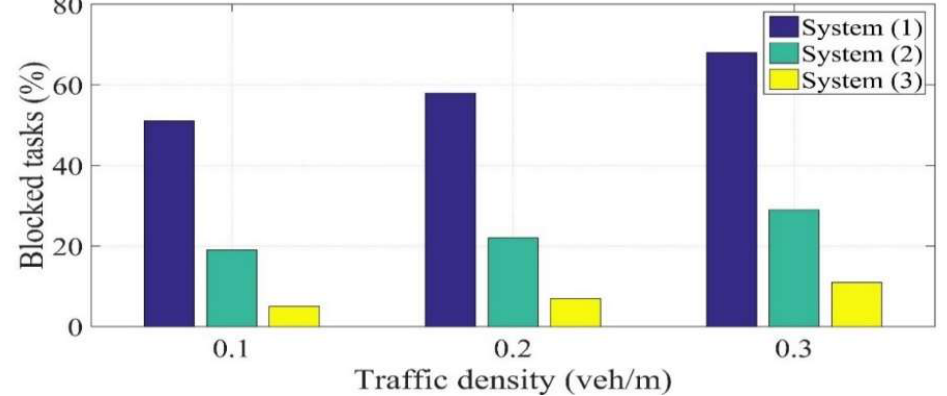
Figure 10. Percentage of blocked tasks for the three systems at different traffic densities.